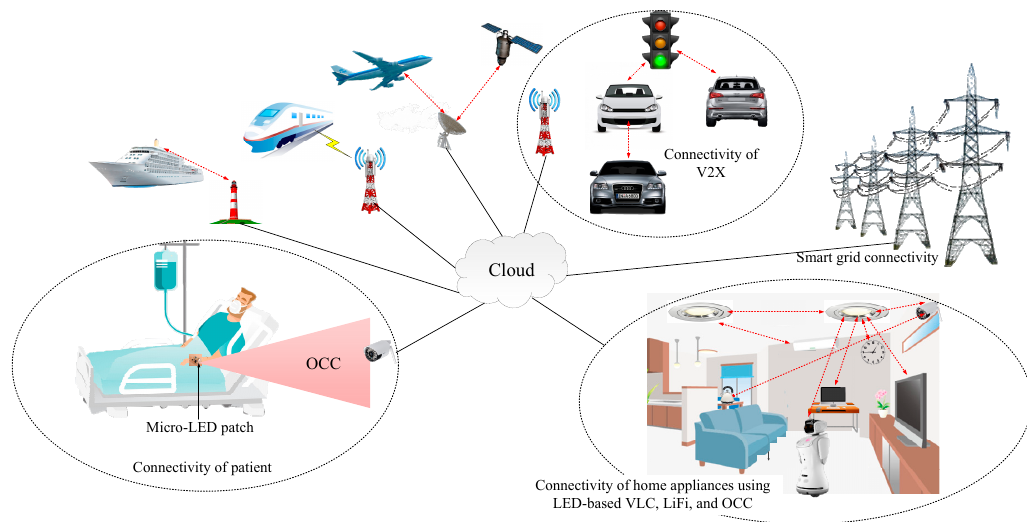
Figure 6. Few examples of massive connectivity using the OWC technologies.